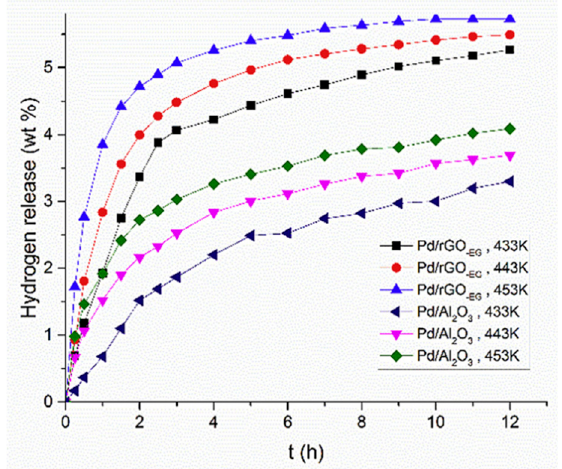
Figure 5. Plots of hydrogen content with time under different temperatures (433, 443, and 453) and under different supports (Al 2 O 3 and rGO -EG ); copyright (2017), Elsevier.